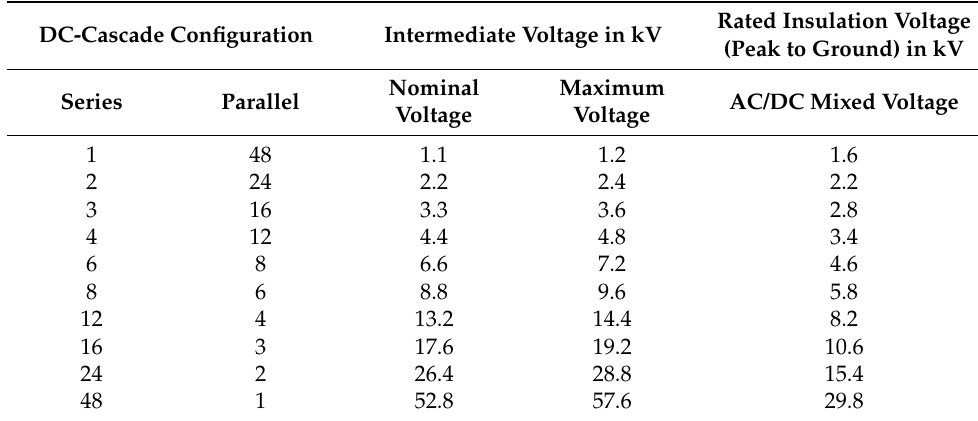
Figure 2. DC-cascade in the configuration S12P4. Table 1. DC-Cascade Configuration. Table 1. DC-Cascade